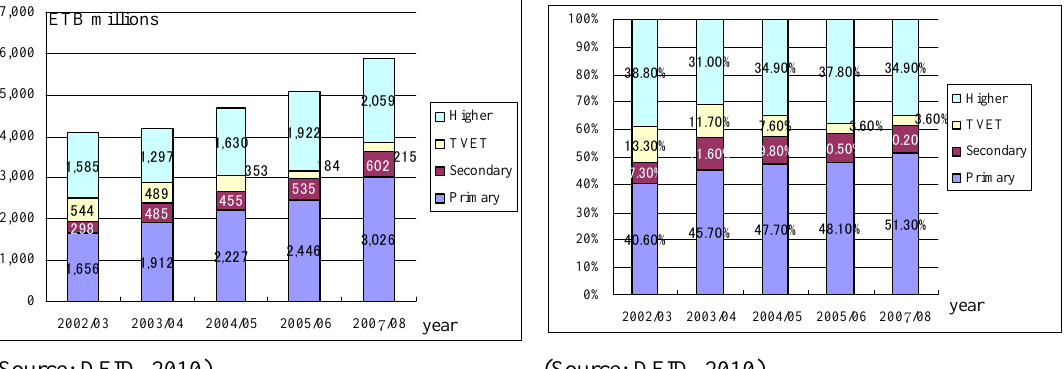
Figure 5-2: Education Expenditure by Education Sub-sector (2002/03 - 2007/08) (constant 2003/04 price, million ETB)